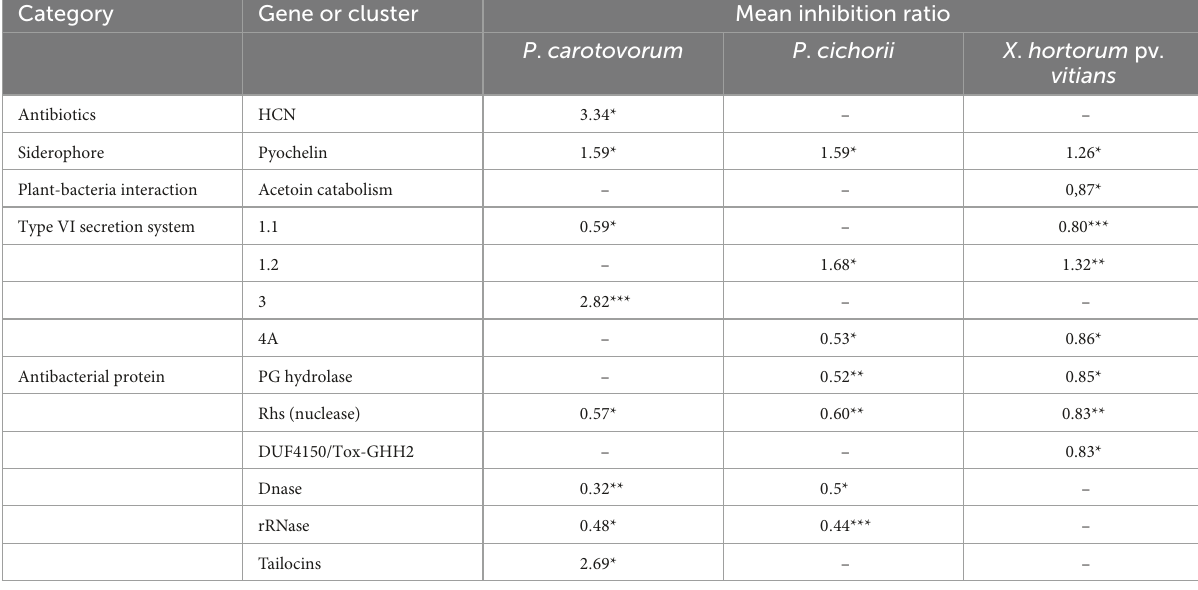
TABLE 2 Mean inhibition ratios and associated p -values between strains displaying and strains not displaying a given gene or gene cluster in their genomes, considering inhibition against P . carotovorum , P . cichorii , or X . hortorum pv. vitians .